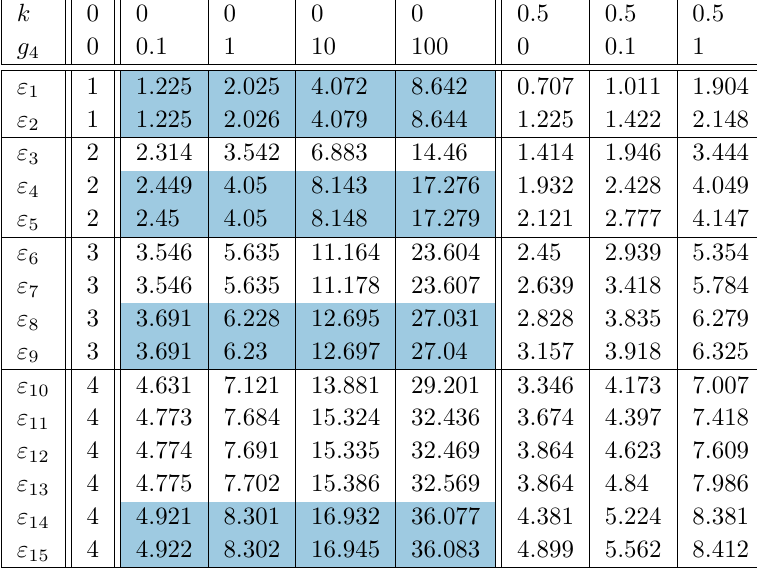
Table 13. Two-matrix spectrum with loop length truncation l = 4 .